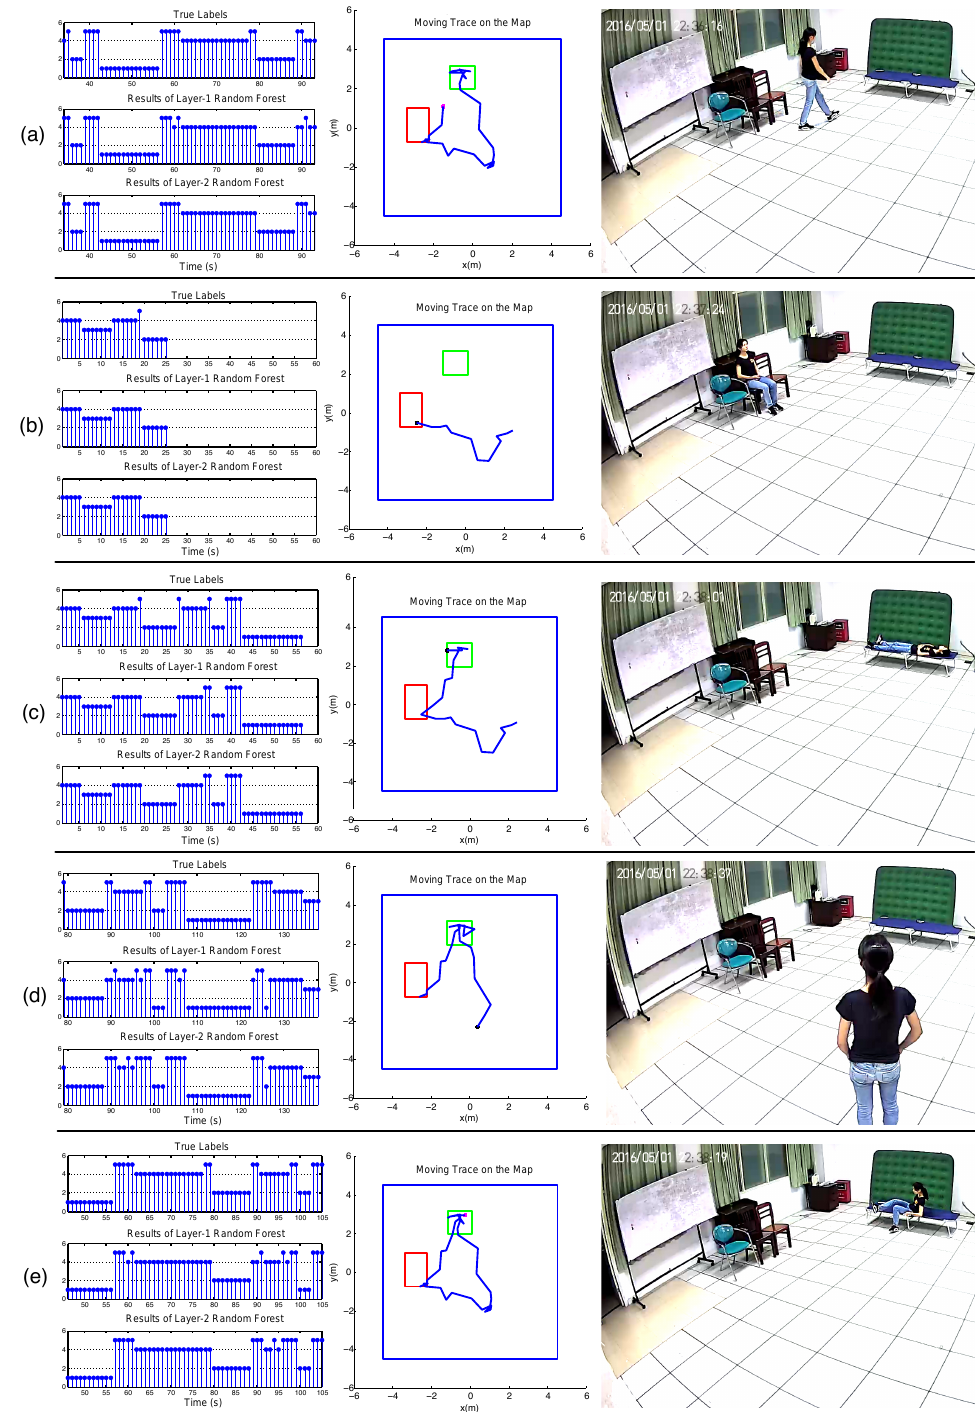
Figure 12. Typical snapshots of video, moving trace of the human target, and the classification results of our two-layer RF. ( a – e ) The left column represents the ground truth labels of each second, the results of the first-layer RF, and the results of the second-layer RF, respectively. The y-axis represents the activity classification result of each second (s): 1. lying, 2. sitting, 3. standing, 4. walking, 5. transitional activities. The middle column is the moving trace of the human target on the map. The red square is the region of chairs, and the green square is the location of the bed. The right column is the snapshot captured from the video, where (a–e) represent walking, sitting, lying, standing, and lie-to-sit,